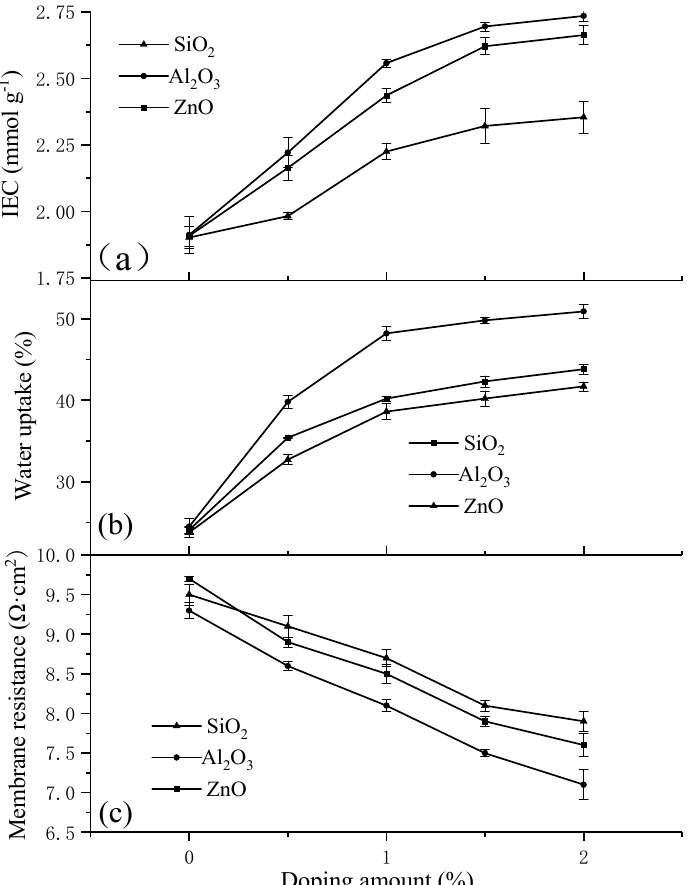
Figure 4. The effect on ion exchange capacity (IEC) ( a ), water uptake (WU) ( b ) and membrane resistance ( c ) of prepared membranes under different doping amounts of nano-SiO 2 , nano-Al 2 O 3 and nano-ZnO.